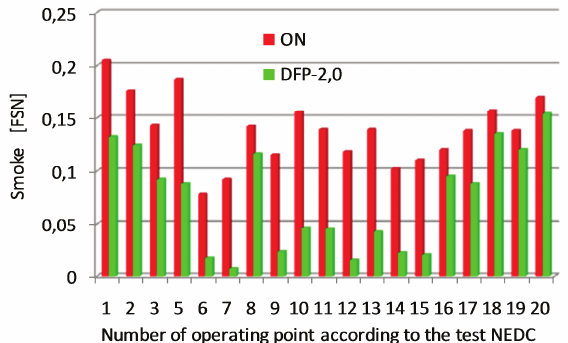
Fig 8. Comparison of smokiness of exhaust gases of Fiat 1.3 MJT engine fueled traditionally and in dual fuel system with correction of output of air: air output at duel fuel feeding was the same as at fueling with diesel oil, opening time of gas injectors 2.0 ms